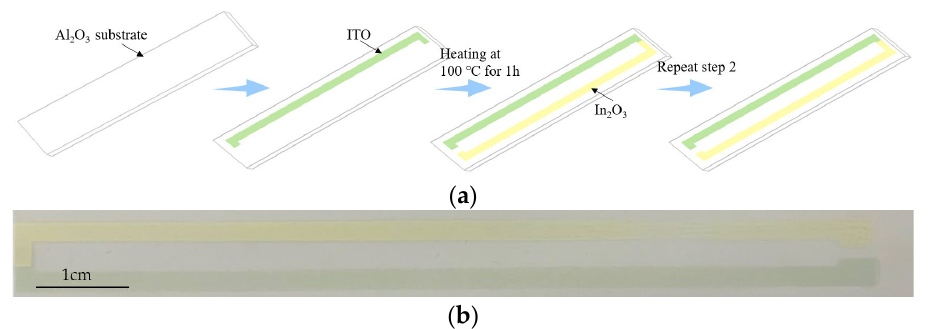
Figure 1. ( a ) Fabrication process of ITO/In 2 O 3 TFTCs by screen-printing. ( b ) Optical image of the ITO/In 2 O 3 thermocouple.